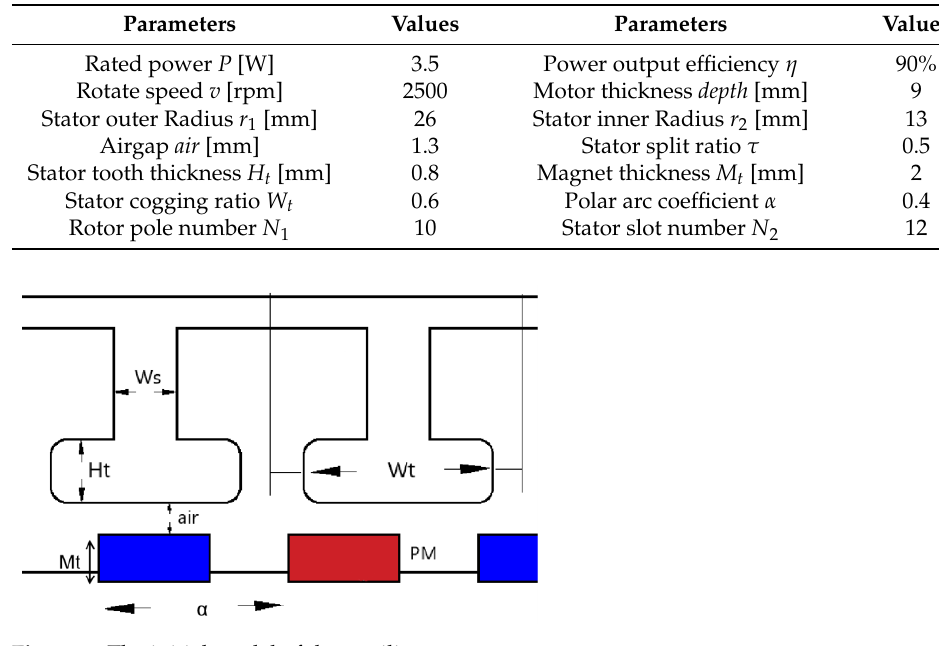
Figure 3. The initial model of the auxiliary